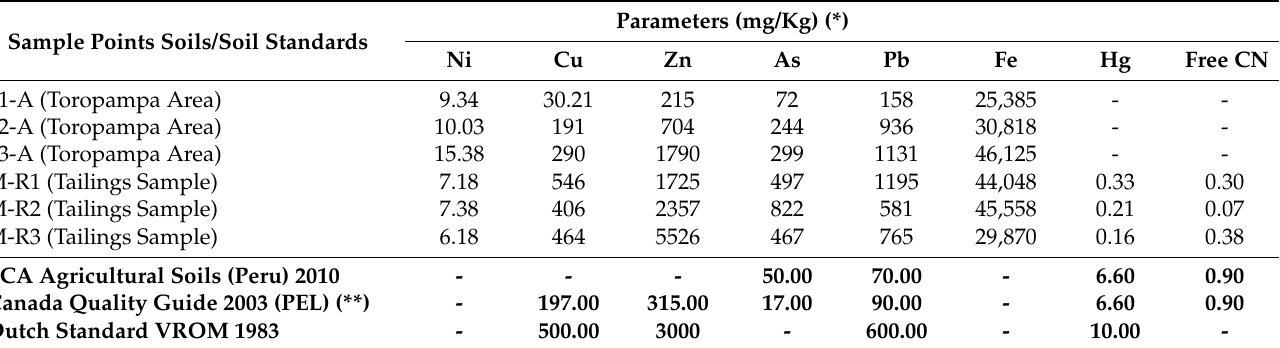
Table 3. Soil Quality and Tailings Monitoring Compared to Soil Standards [45].